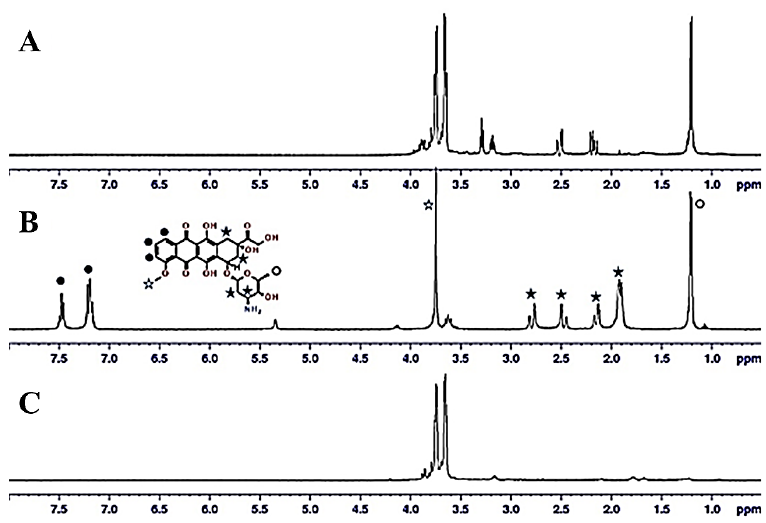
Figure 6. 1 H NMR spectra (400 MHz, D 2 O) of the sAuNP-doxorubicin conjugate ( A ), doxorubicin ( B ) and the sAuNPs alone ( C ) at 298 K using water suppression.